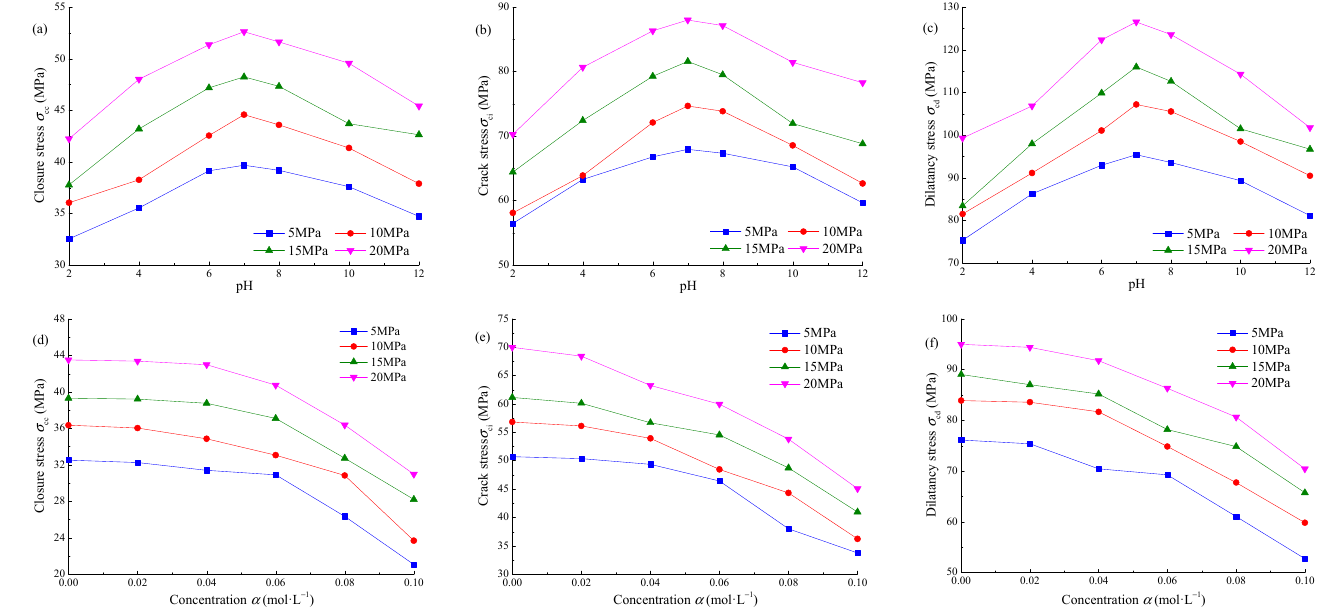
Figure 8. Characteristic stress distribution curve of Na 2 SO 4 corroded sandstone: ( a ) closure stress σ cc -pH; ( b ) initiation stress σ ci − pH; ( c ) dilatancy stress σ cd − pH; ( d ) closure stress σ cc − α ; ( e ) initiation stress σ ci − α ; ( f ) dilatancy stress σ cd − α .